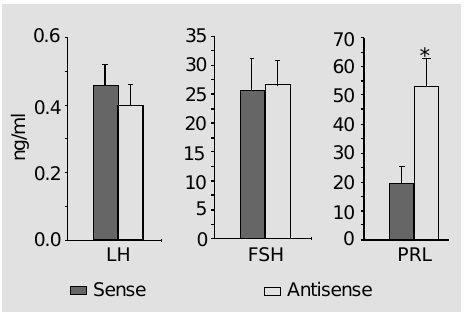
Figure 1 - Effect of four microin- jections of sense or antisense mRNA oligonucleotides (250 ng) for neuropeptide Y-Y 1 recep- tors into the medial preoptic area at 12-h intervals on luteiniz- ing hormone (LH), follicle-stimu- lating hormone (FSH) and pro- lactin (PRL) secretion in ovariec- tomized rats treated with estro- gen (50 µg) and progesterone (25 mg). Values are reported as means ± SEM for 8 animals. *P<0.02 vs sense group (con- Sense Antisense